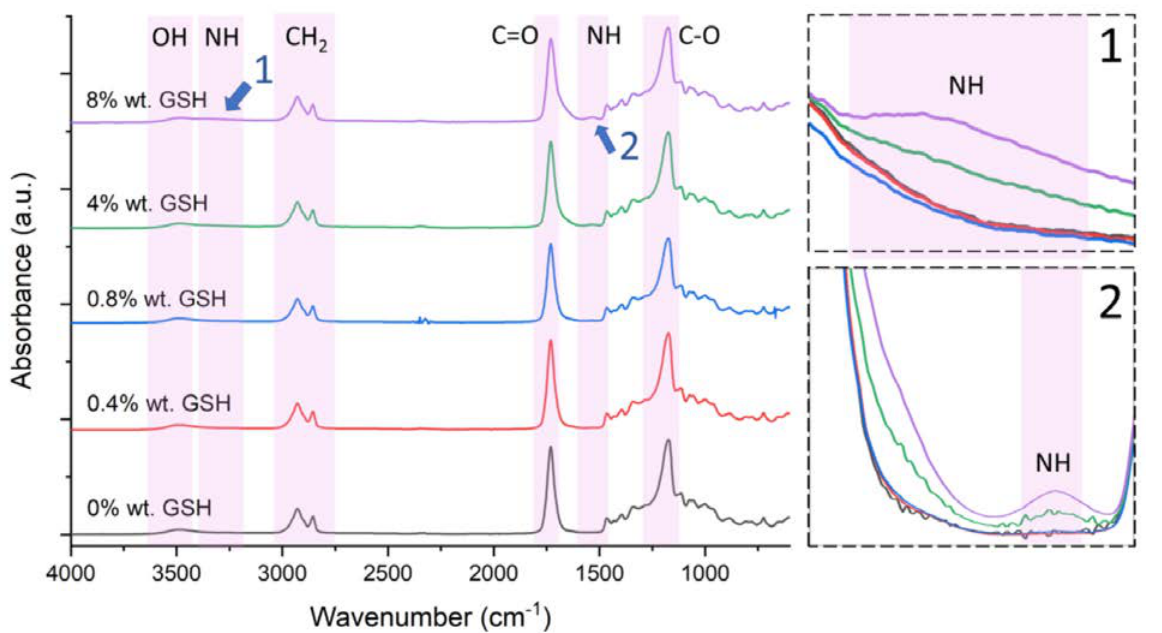
Figure 2. FTIR spectra of cPOC non-modified (0 wt.% of GSH) and modified with 0.4, 0.8, 4 and 8 wt.% of GSH.